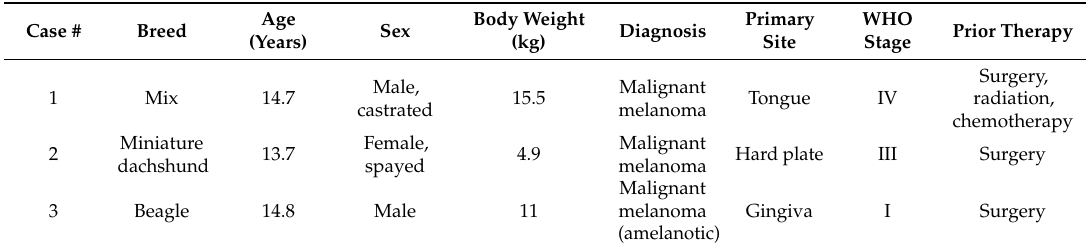
Table 1. Characteristics of dogs treated with P38Bf.